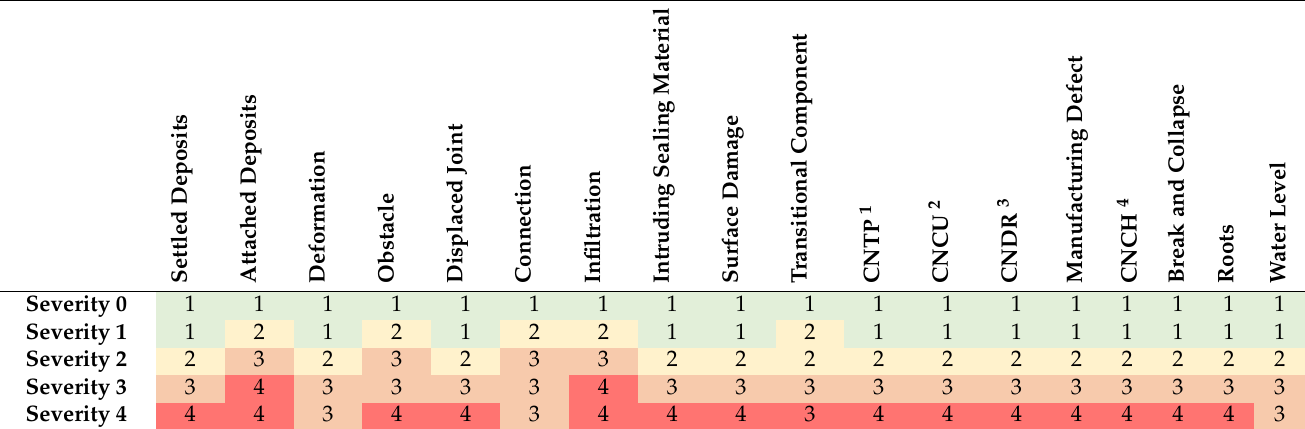
Table 2. Overview of how a CCTV-observation of a defect with severity zero to four entails the condition state to be in state one to four.